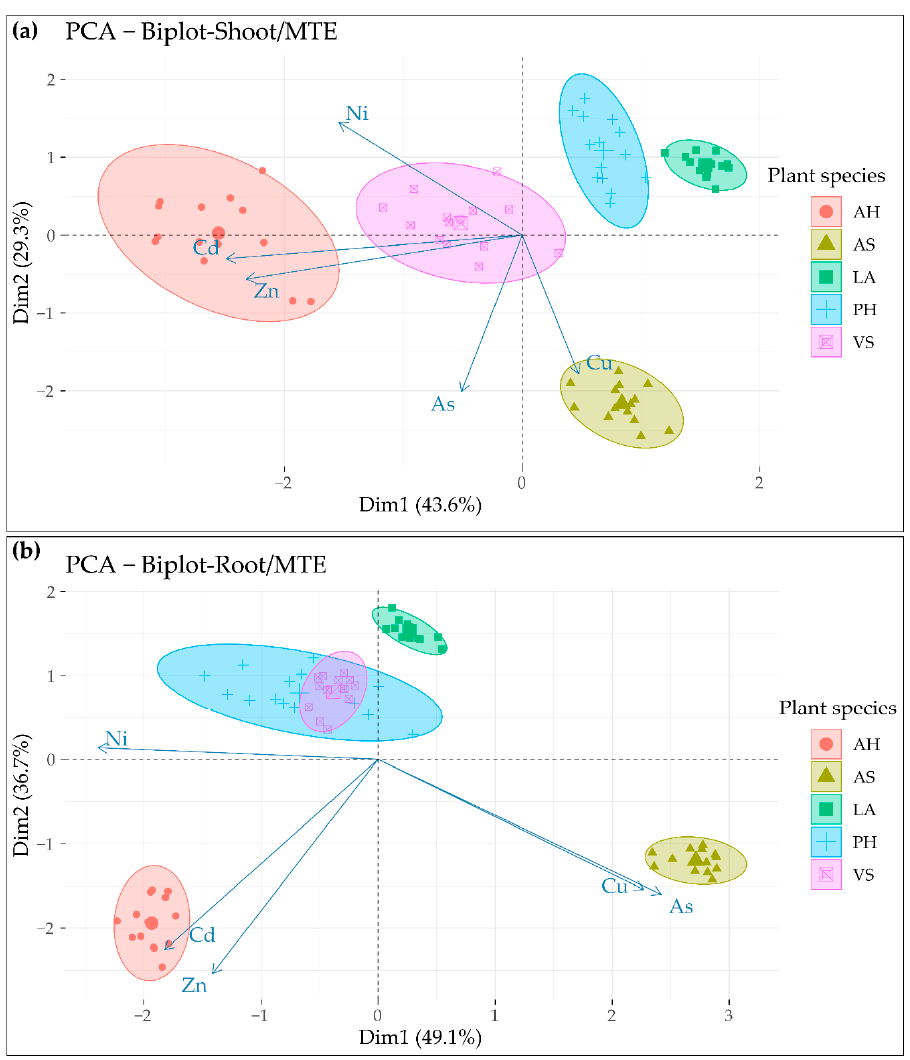
Figure 5. Principal component analysis (PCA) obtained for the concentrations of five metallic trace elements (MTEs) in the shoots ( a ) and the roots ( b ) of the plant species Asparagus horridus L. (AH), Atriplex semibaccata R. Br. (AS), Launaea arborescens (Batt.) Murb. (LA), Peganum harmala L. (PH), and Vicia sativa L. (VS).